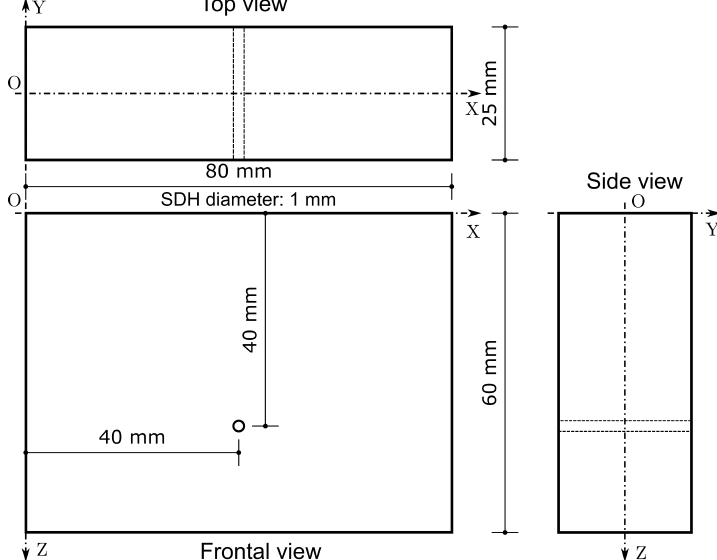
Figure 4. Geometry of the first inspected object. It was manufactured of steel and has a SDH with 1 mm of diameter, centered at x = 40 mm and z = 40